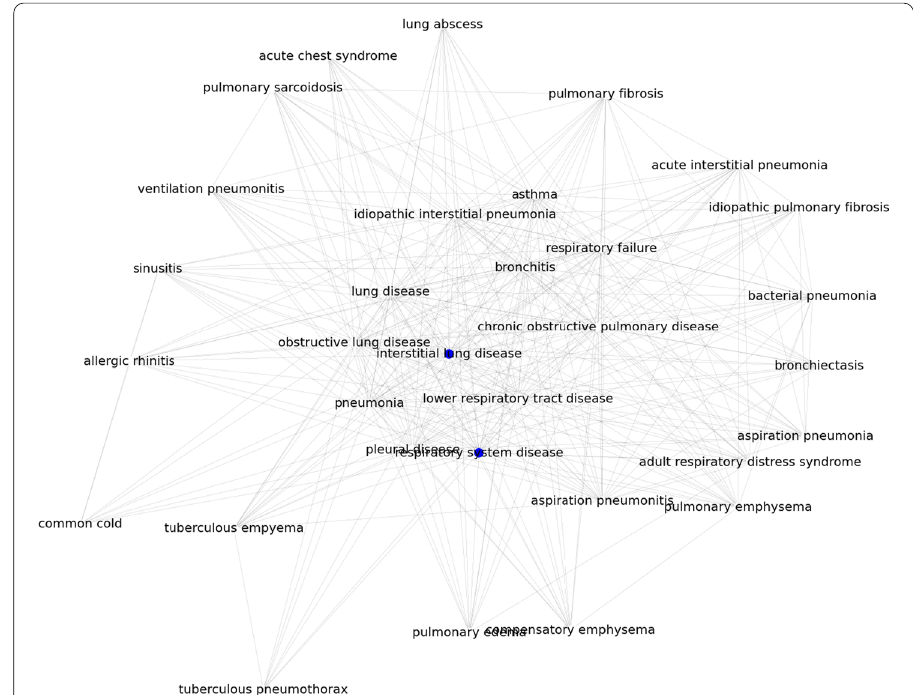
Fig. 5 Respiratory system community diseases. Blue nodes indicates comorbid significant diseases